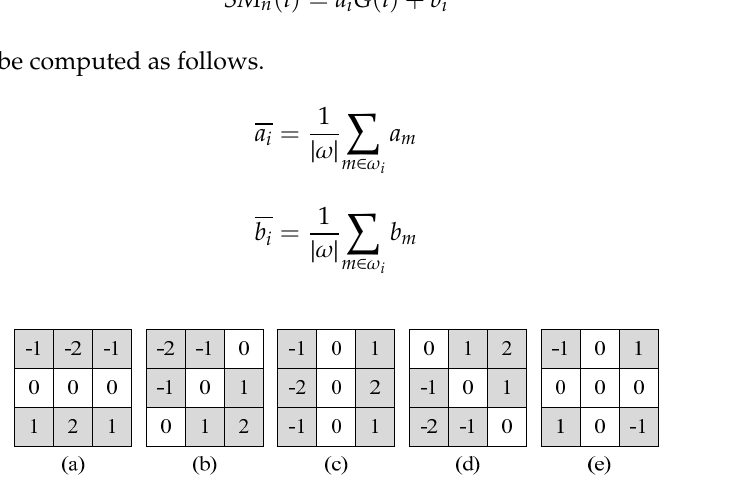
◦ , ( b ) 45 ◦ , ( c ) 90 ◦ , ( d ) 135 ◦ , and ( e ) no Figure 3. Sobel filters of five orientations at ( a ) 0°, ( b ) 45°, ( c ) 90°, ( d ) 135°, and ( e ) no orientation. Figure 3. Sobel filters of five orientations at ( a ) 0